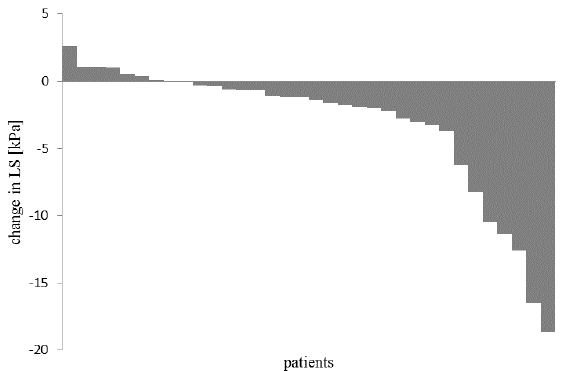
Figure 1. Reduction of liver stiffness between EOT and FU96 in individual patients. Each column represents one patient and the change in liver stiffness between end of treatment and 96 weeks later.